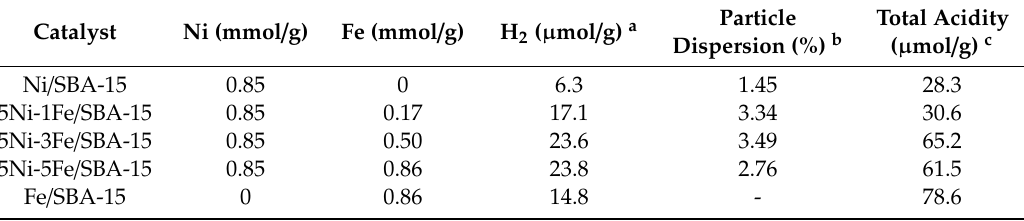
Table 1. Chemical properties of the synthesized monometallic Ni / SBA-15, Fe / SBA-15, and bimetallic Ni-Fe / SBA-15